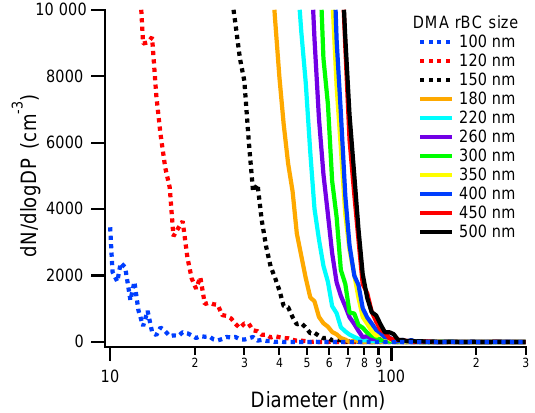
Figure 4. Size distribution of SP2 exhaust from different sized- selected rBC particles. The concentration of size-selected rBC par- ticles was approximately 1000cm − 3 and the sheath:sample was 4.9:1.